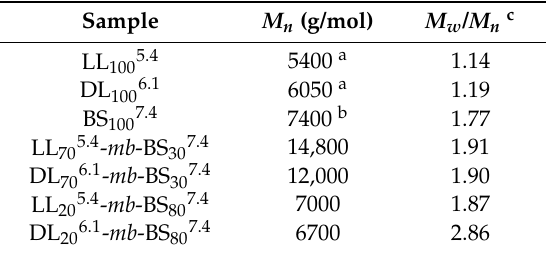
Table 1. Molecular characteristics of the PLA and PBS homopolymers and